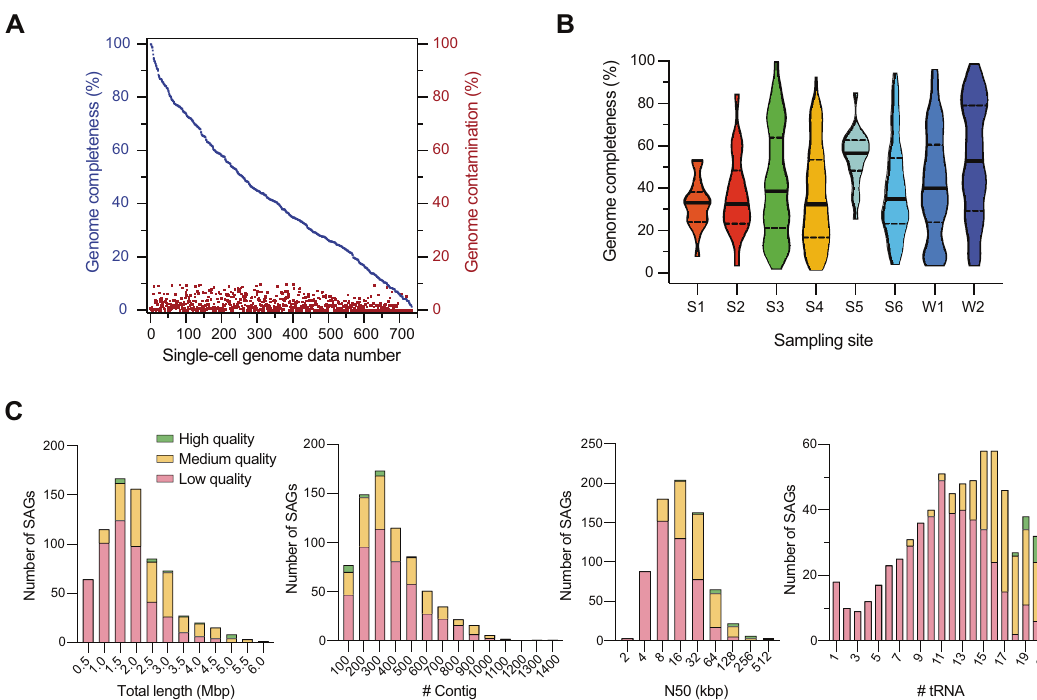
Fig. 2 Sequence statistics for 734 SAGs collected from eight environmental samples. A Genome completeness and contamination of 734 SAGs obtained from eight environmental sites. B Distributions of SAG completeness for the eight environmental samples including six soil samples (beach soil: S1; desert soil: S2; mangrove soil: S3; fresh sea sediment: S4; frozen sea sediment: S5; and seashore soil: S6) and two seawater samples (harbor seawater: W1; and open-ocean seawater: W2). Solid line is the median and the dotted line is the quartile. C Distributions of the total length, the number of contigs, N50, and the number of tRNA classi fi ed by the quality of